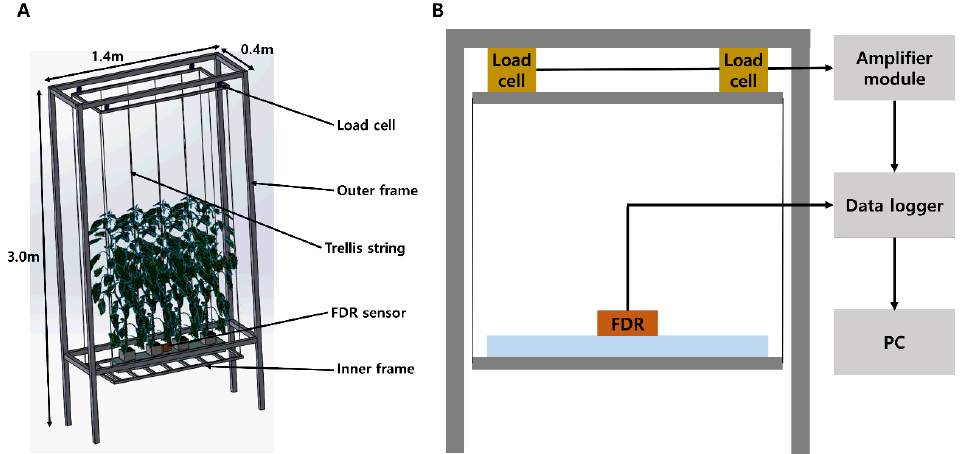
Figure 1. A schematic diagram of the developed fresh weight measuring system using load cell and frequency domain reflectometry (FDR) sensors ( A ) and the data flow of the developed system ( B ).